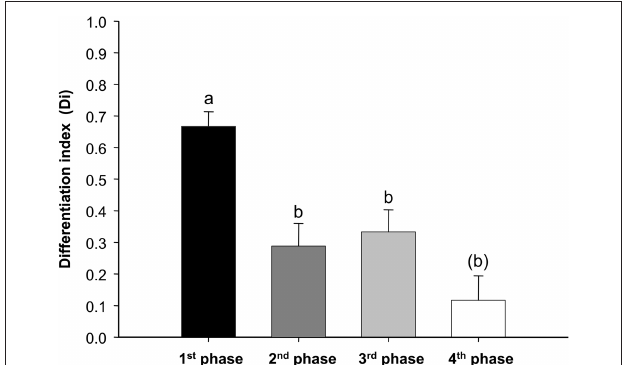
– CS − ). The trial5 trial5